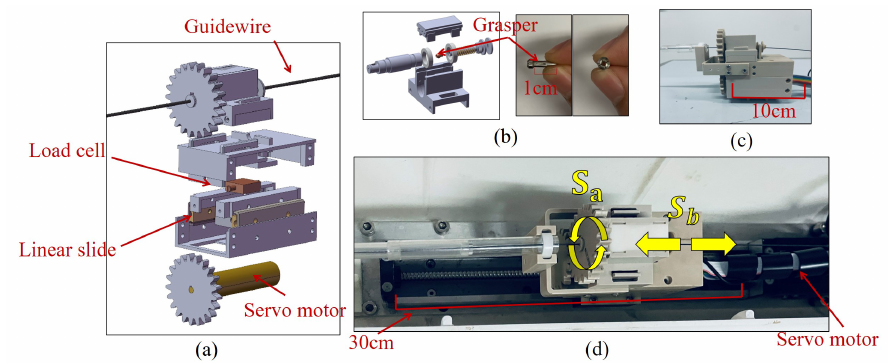
Figure 3. The slave end drives the guidewire to translate and rotate through a tiny gripper. ( a ) Struc- ture diagram. ( b ) Guidewire gripper. ( c ) Prototype ( d ) Slave end.